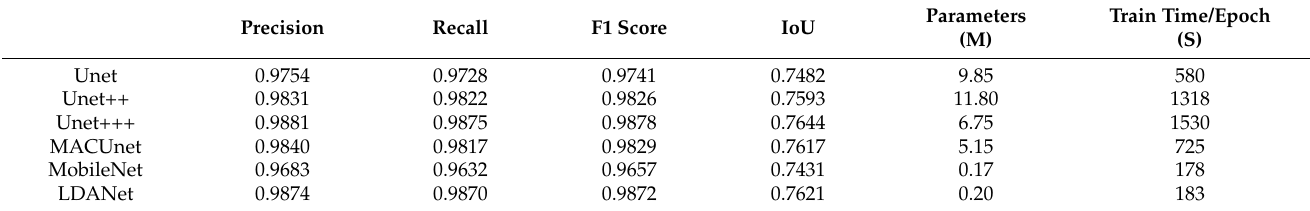
Table 2. Comparison of six models evaluated on the rural roads dataset.